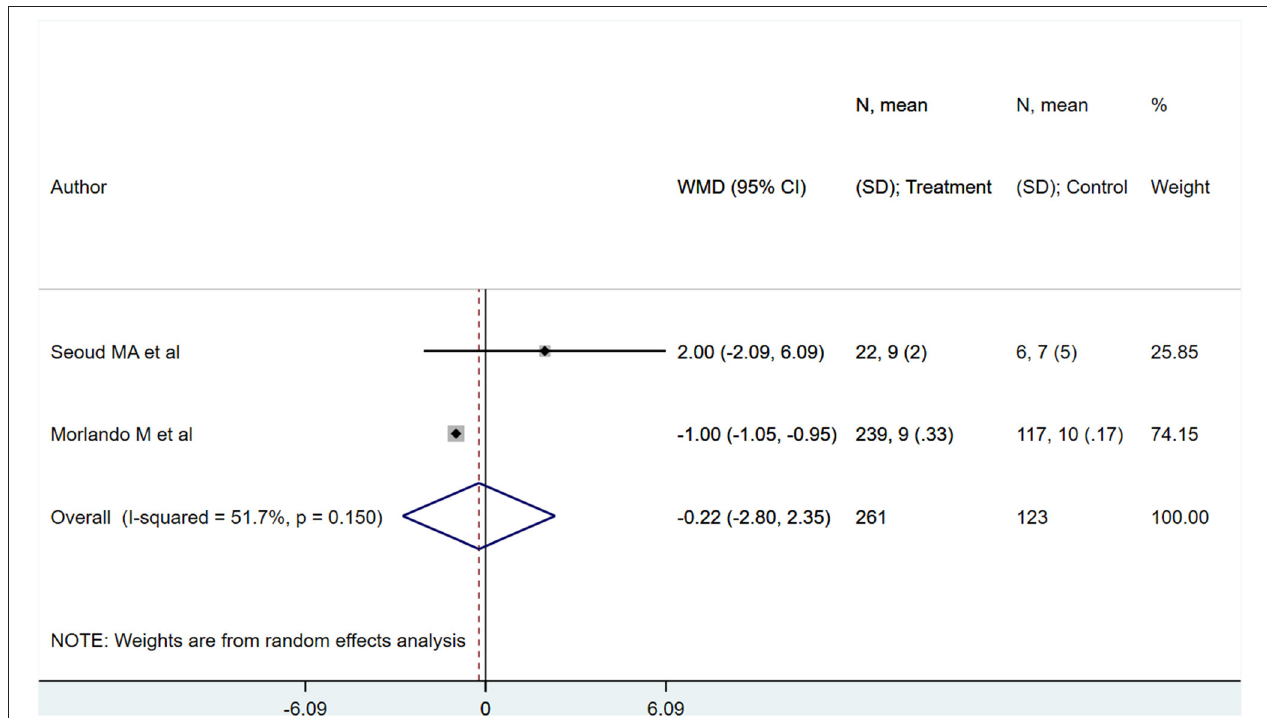
FIGURE 8 | APGAR score at 5min for babies born to PAS patients via planned or emergency